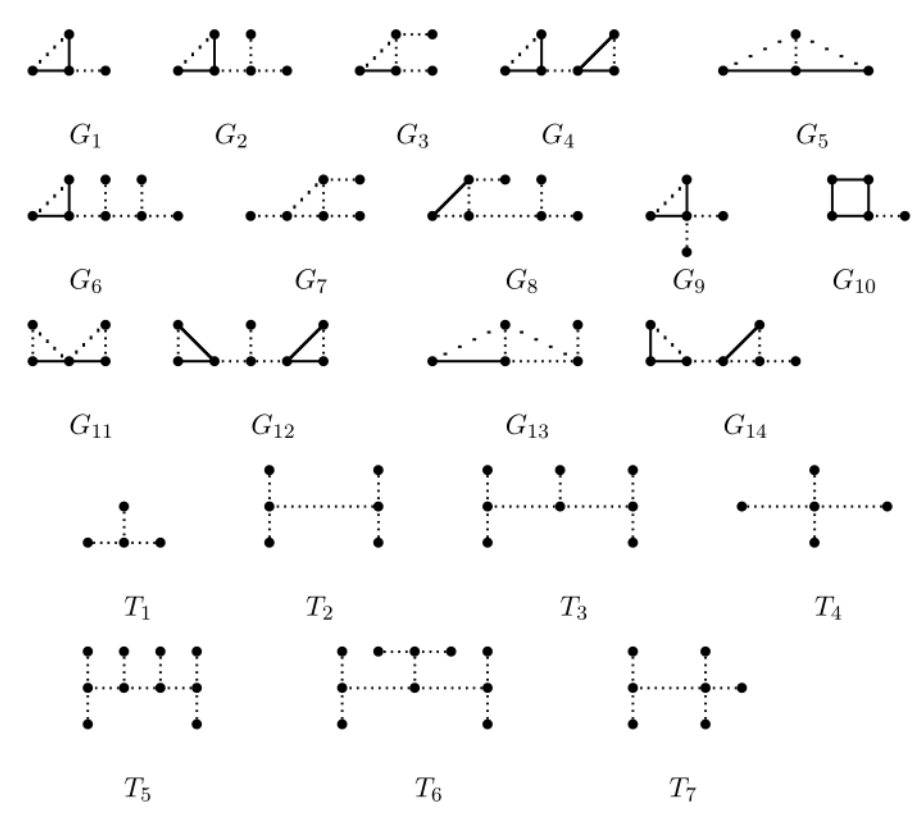
Figure 1. Some connected graphs Π 1 ≥ −